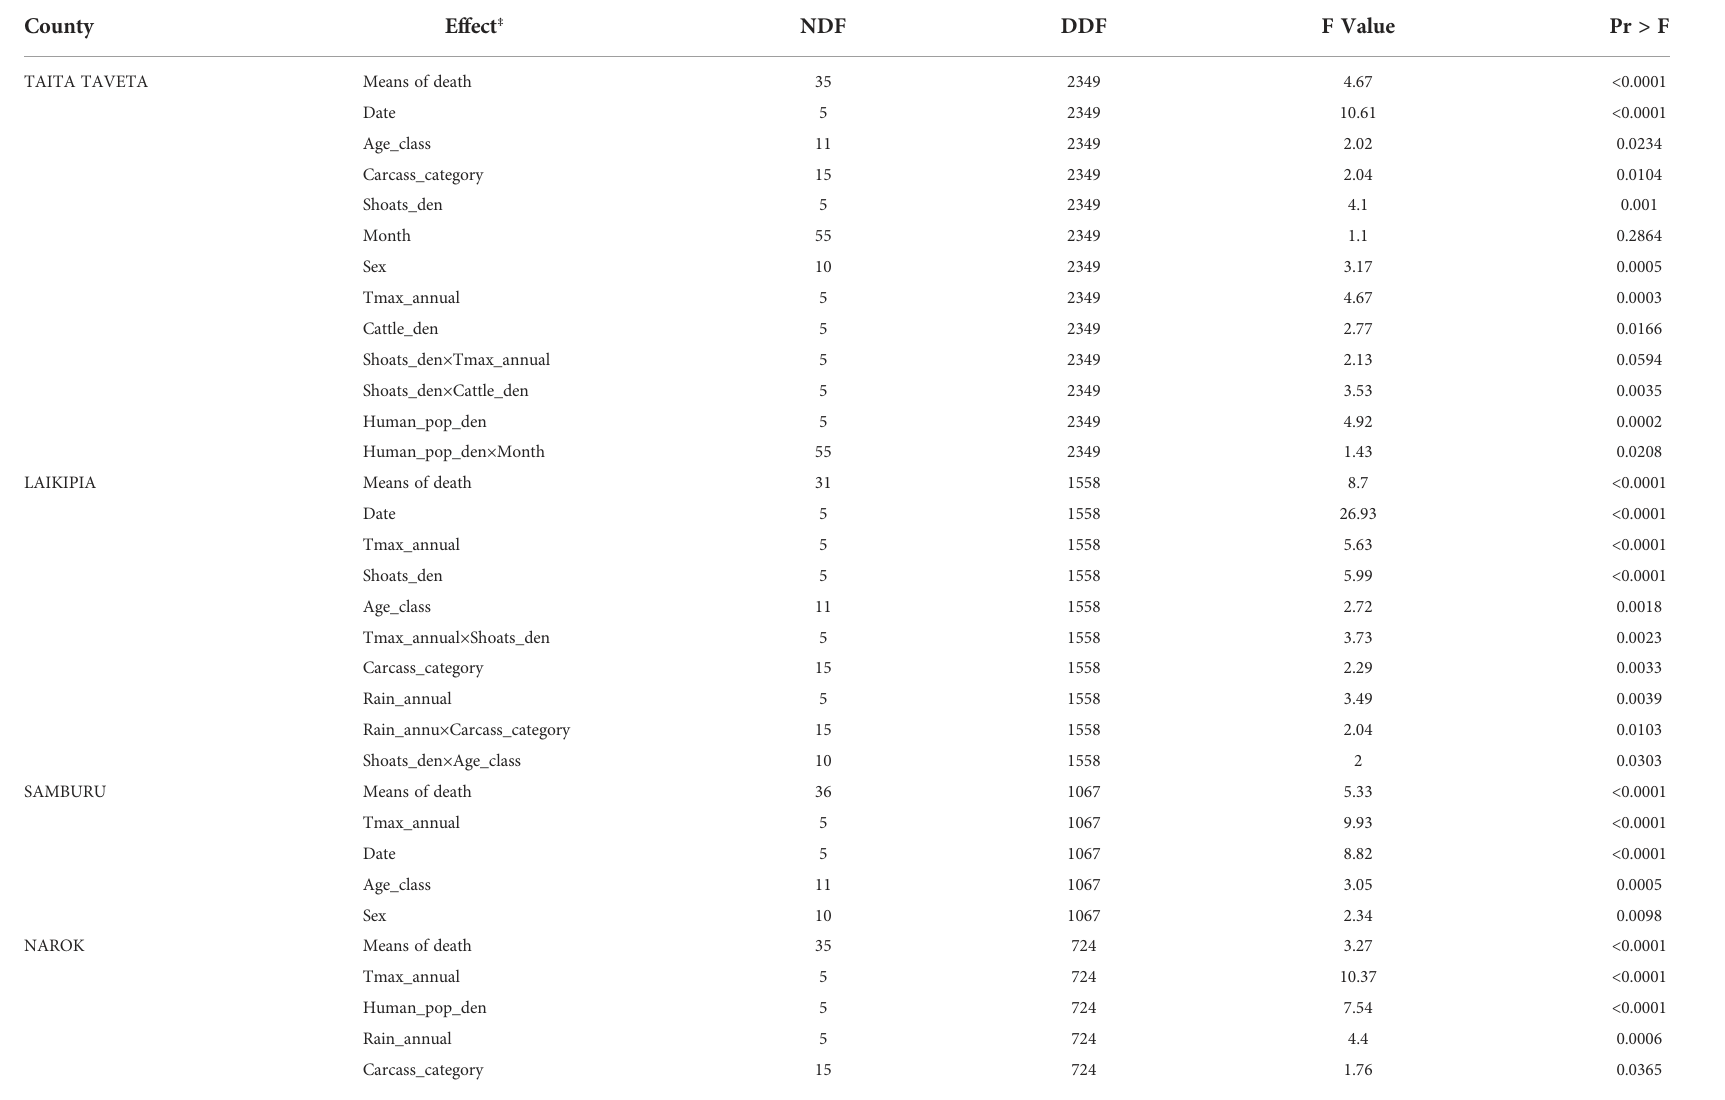
TABLE 4 F tests of the signi fi cance of the effects retained in the fi nal model relating elephant mortality probability (cause of death=ivory poaching set as the baseline category) to predictor variables and their interactions. County Effect ‡